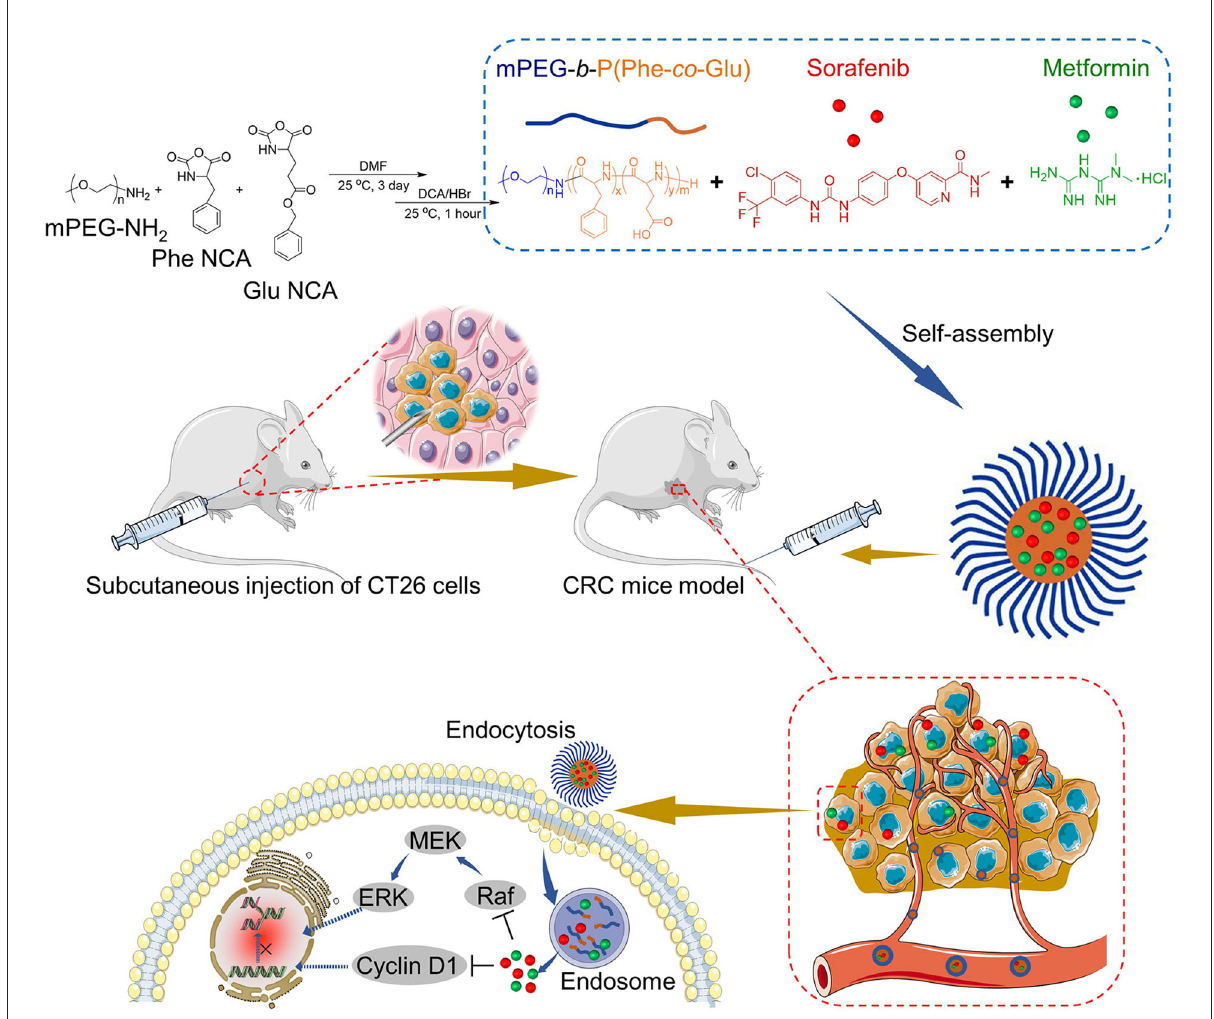
FIGURE1 Synthesis of Met/Sor-loaded mPEG- b -P(Glu- co -Phe) micelles and their mechanisms of CRC prevention.